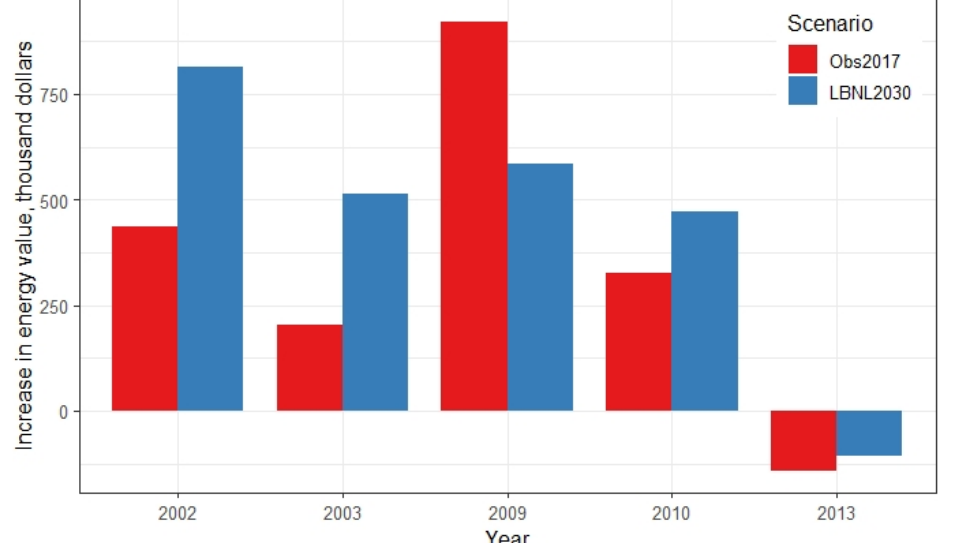
Figure 9. The annual increase in energy value using the enhanced forecasting method under two price scenarios.